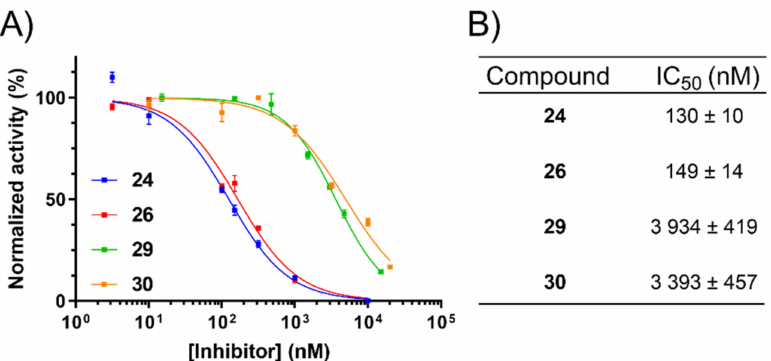
Figure 4. Inhibition of MDA-MB-231 cell-surface uPA activity. ( A ) Dose-response curves for 24 , 26 , 29 , and 30 . Data represent the mean ± SEM ( n = three technical replicates/concentration). ( B ) Average IC 50 values ± SEM from four independent